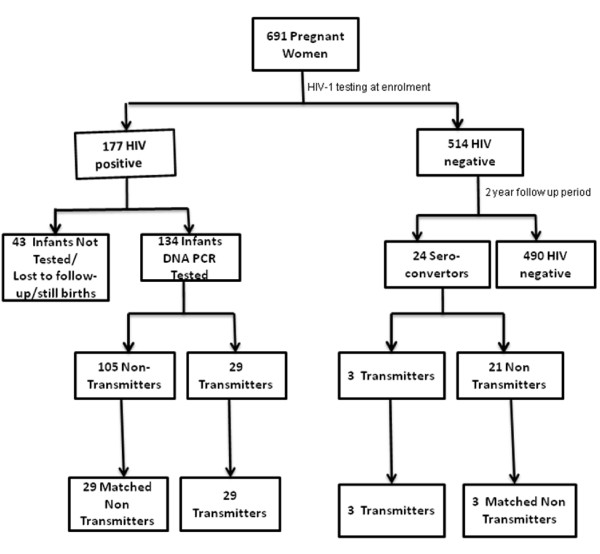
Summary of the sampling of the 32 transmitters and 32 non-transmitters.